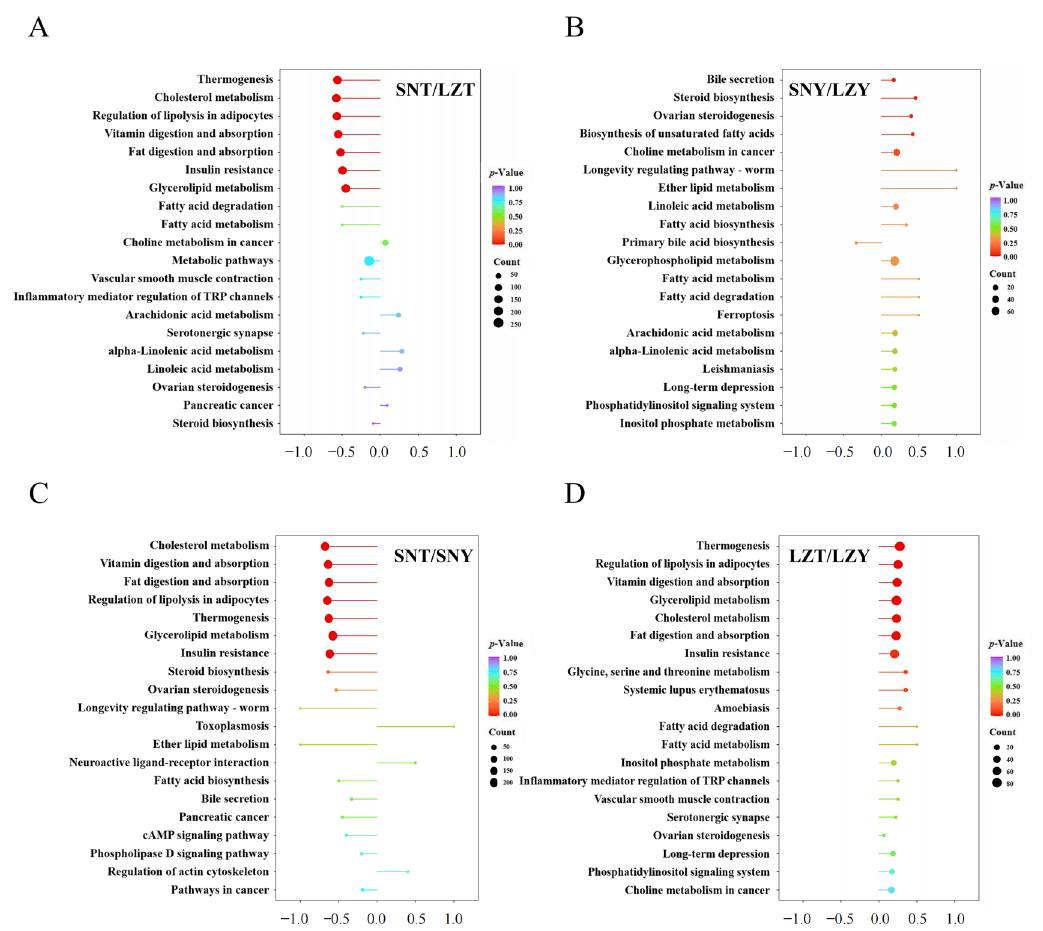
Figure 3. KEGG analysis of pig liver DALs for different breeds raised at different altitudes. ( A ) SNT/LZT; ( B ) SNY/LZY; ( C ) SNT/SNY; and ( D ) LZT/LZY. The X-axis represents the differential score, the differential abundance score = (number of differential metabolites upregulated in the pathway—number of differential metabolites downregulated in the pathway)/number of all metabolites annotated to the